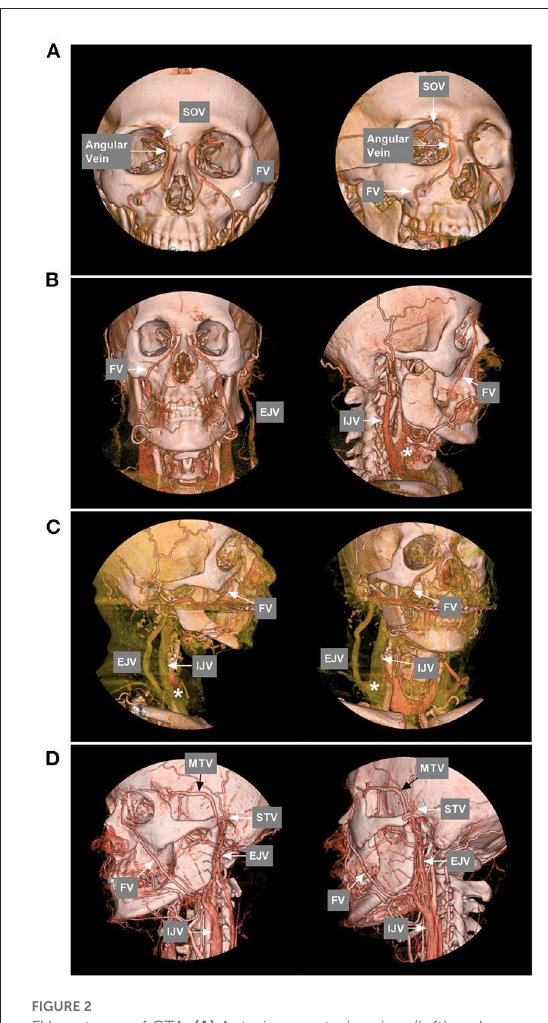
FIGURE2 FV anatomy of CTA. (A) Anterior–posterior view (left) and oblique (right) view of CTA show that the SOV from the CS connected with the angular vein; then, the angular vein continued as the FV. (B) Anterior–posterior view (left) and oblique (right) view of CTA show that the typical FV descends obliquely in a straight line to continue the common FV and flow with the IJV. The asterisk (right) indicates the junction of the FV with the IJV. (C) Lateral view (left) and oblique (right) view of CTA show the FV together with the EJV into the IJV. The asterisks (left and right) indicate the junction of the FV into the IJV. (D) Lateral view (left) and oblique (right) view of CTA show that the MTV joins the STV to form the EJV and then connects with the FV into the IJV; in the face, many tidy veins join into the FV. CS, cavernous sinus; CTA, computed tomography angiography; EJV, external jugular vein; FV, facial vein; IJV, internal jugular vein; MTV, middle temporal vein; SOV, superior ophthalmic vein; STV, superficial temporal vein.